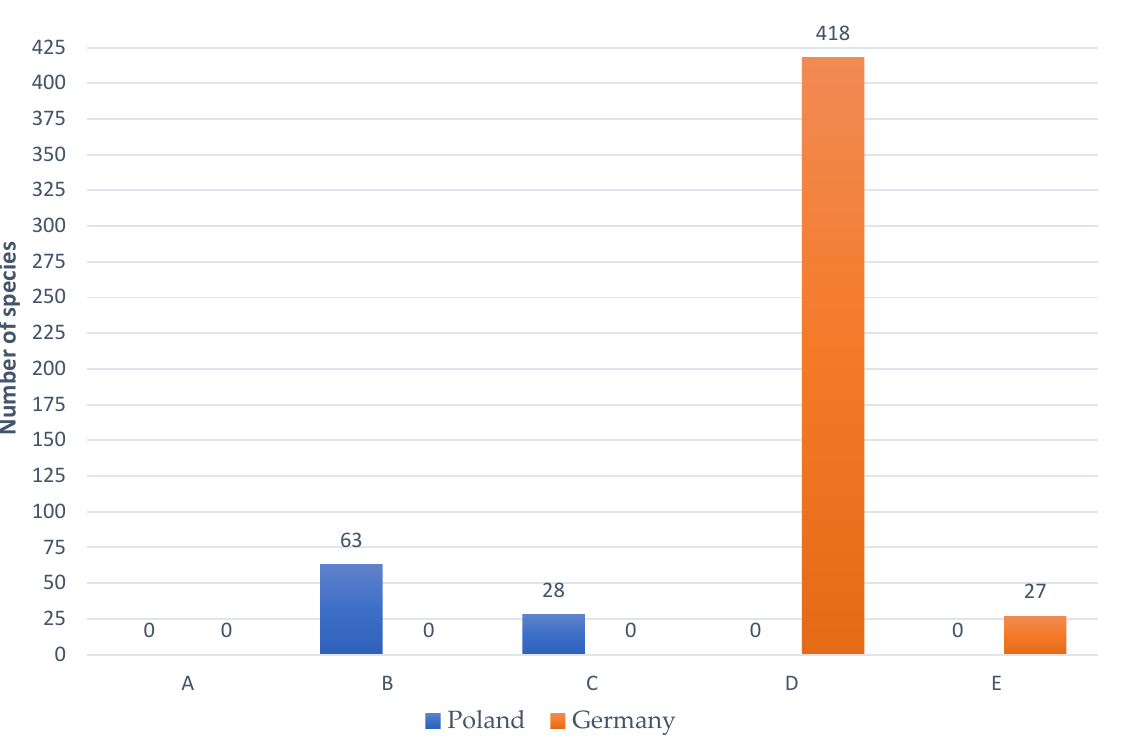
Figure 3. Frequency class distribution of weed species in winter cereals in Poland and Germany (frequency classes: A = ≥ 80, B = 61–80.9; C = 41–60.9; D = 21–40.9; E = ≤ 20%).